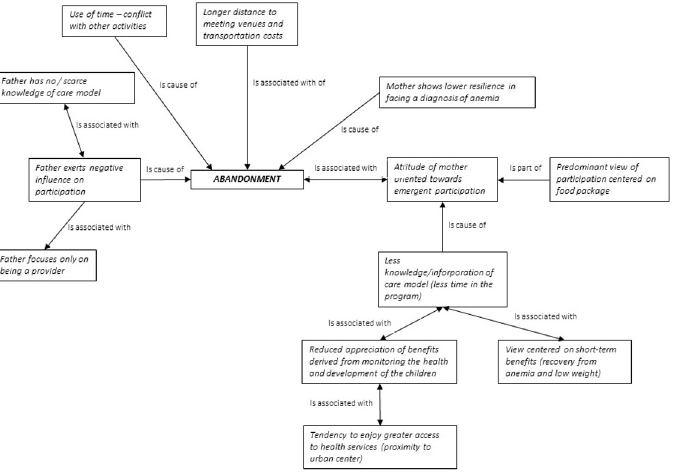
Fig 4. Factors related to abandonment of ECD programs, Oaxaca, 2019. Source: Elaborated by the author using Atlas-Ti, V7 software [56].